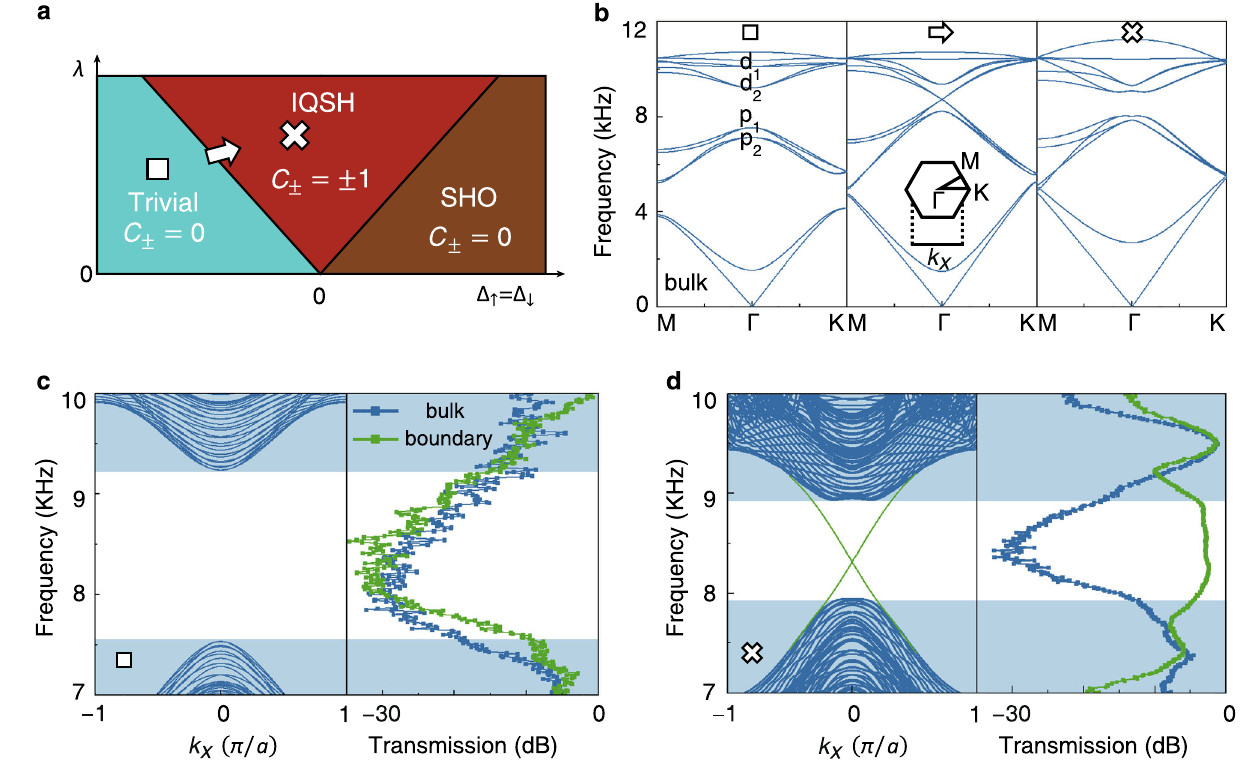
Fig. 3 | Trivial and IQSH phases. a Topological phase slice when Δ " = Δ # . Insets show spin – Chern numbers. b Bulk bands inversion associated with the phase transition from the trivial to the IQSH phases. c , d Numerical projected band